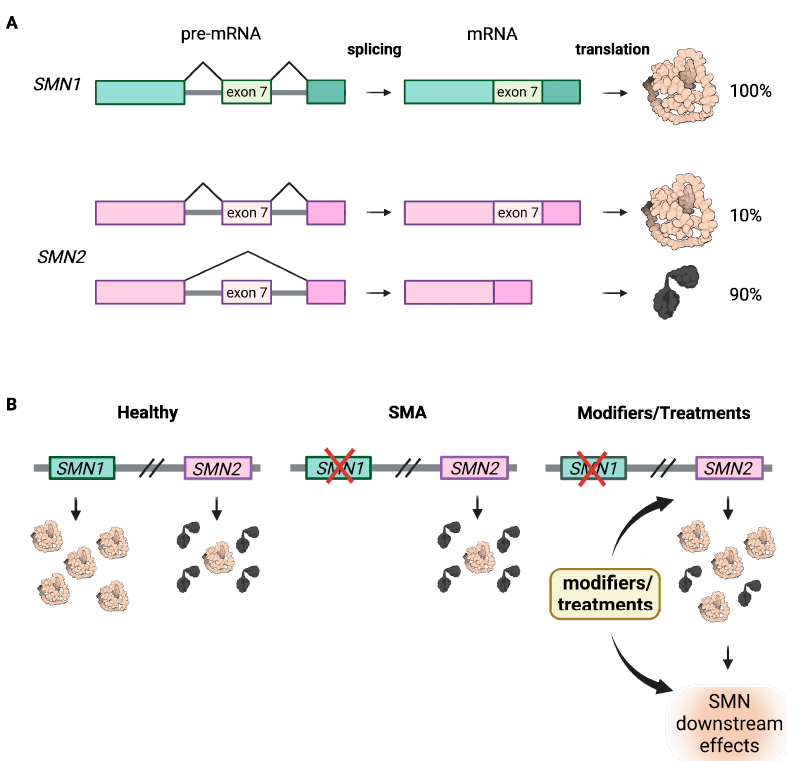
Figure 1. Genetic basis of SMA. ( A ) SMN1 and SMN2 genes are located on chromosome 5q13 and encode for SMN protein. In healthy conditions, the SMN1 pre-mRNA undergoes correct splicing, while SMN2 pre-mRNA mainly undergoes erroneous splicing, which results in the loss of the exon 7 and the translation of a truncated and non-functional SMN protein. ( B ) Healthy individual present physiological levels of SMN protein, deriving mainly from the SMN1 gene. In SMA patients, deletion of or missense mutations in SMN1 cause a dramatic reduction in SMN protein level that cannot be compensated by the SMN2 copy gene. The SMN protein levels can be (partially) restored by genetic modifiers or treatments that either boost the production of SMN protein ( SMN2 copy number is a modifier in this sense) or act on the downstream functions of SMN to compensate its loss. The figure was created with BioReneder.com. To date, three FDA- and EMA-approved drugs have been shown to be effective in ameliorating or restoring motor abilities, particularly if the therapy begins pre-sympto- matically, as is the case when newborn screening has been implemented [13–15]. All three therapies aim to increase SMN levels, either through (i) antisense oligonucleotides that correct splicing by blocking an intronic silencer in intron 7 (intrathecal injection of nusinersen/Spinraza, Ionis Pharmaceuticals and Biogen), (ii) small molecules facilitating the recruitment of U1-snRNPs to the splice donor of intron 7 (systemic oral application of risdiplam/Evrisdy, Gentechen and Roche), or (iii) gene replacement therapy, using a self-